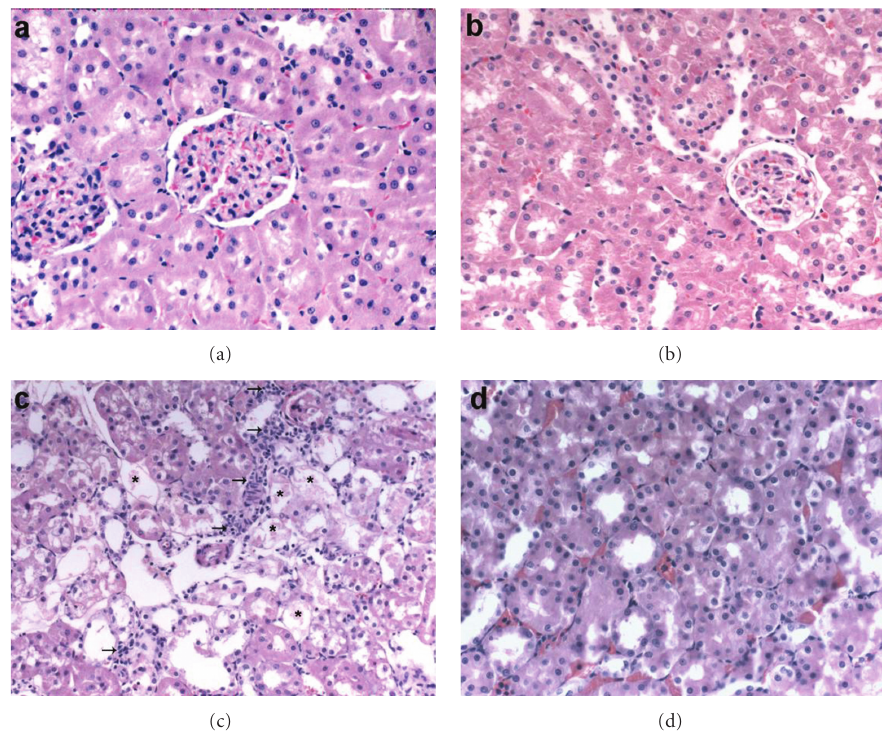
Figure 3: Photomicrograph of rat kidney section. (a and b) Normal histology of kidney tissue in control and SA-treated rats (H&E × 200). (c) Marked tubular necrosis (asterisk) and massive mononuclear cell infiltration (arrow) in cortex of rats in GM-group (H&E × 200). (d) Section from rat treated with gentamicin (100mg/kg) plus salicylic acid (100 mg/kg) reveal almost complete prevention of histopathological alterations (H&E ×